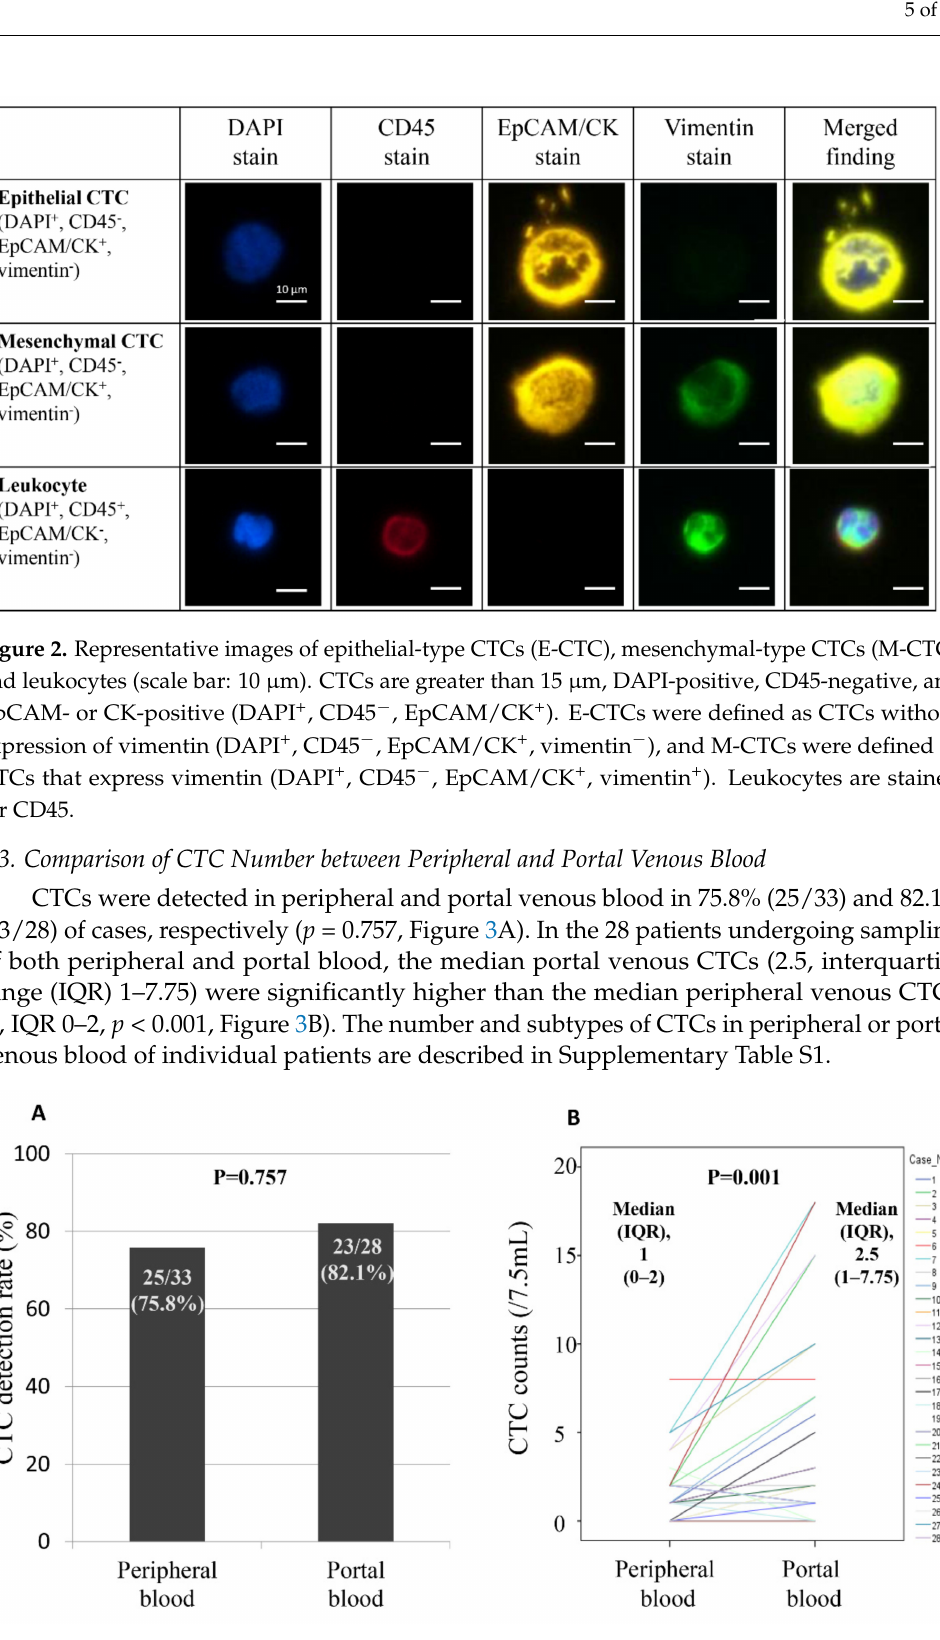
Figure 3. Comparison of CTC detection rate and number between peripheral and portal venous blood. ( A ) CTCs were detected in 75.8% (25/33) and 82.1% (23/28) of samples of peripheral and portal venous blood ( p = 0.757), respectively. ( B ) Median CTC number in the portal vein was significantly higher than that in the peripheral blood (median, 2.5 vs. 1 cells/7.5 mL of blood, p <